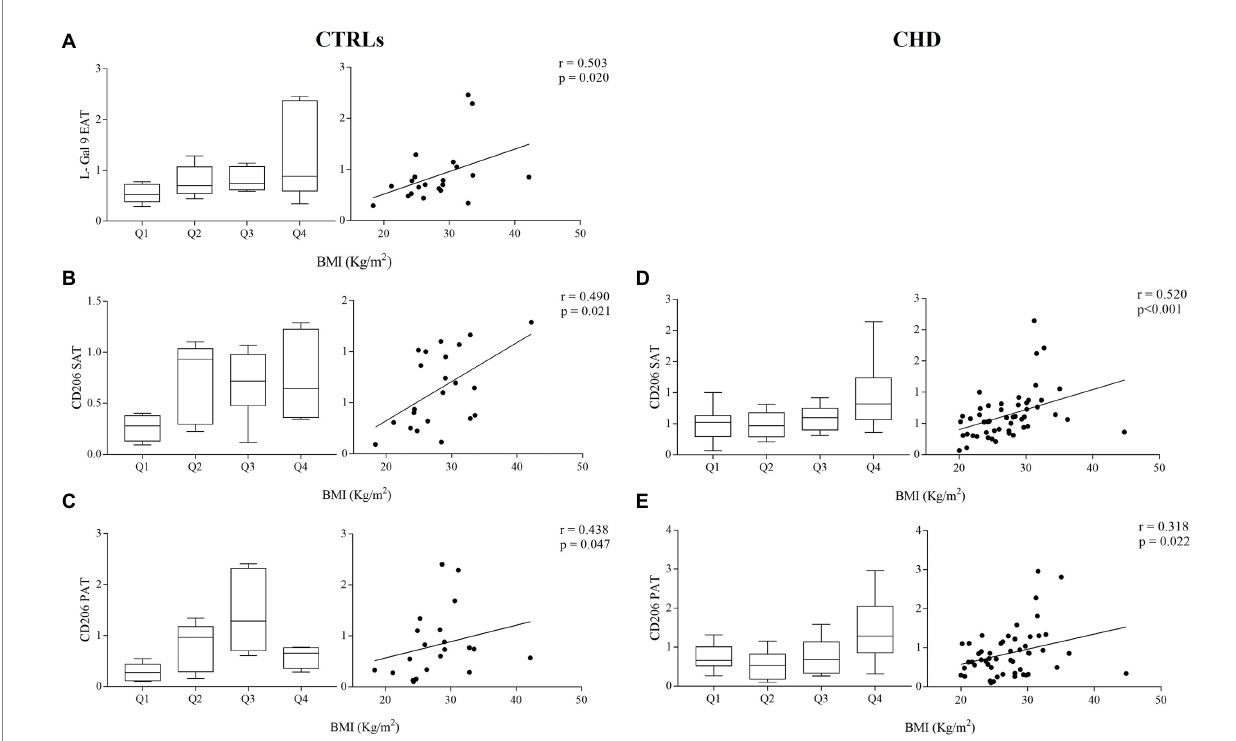
FIGURE 5 Gene expression of L-Gal 9 in CTRLs (A) and CD206 in CTRLs (B,C) and CHD patients (D,E) either stratified based on subject’s BMI quartiles (left graph) or as correlation with continuous BMI values (right graph). Data are reported as RQ values and box plots indicate the median values, 25th and 75th percentiles, while error bars report 10th and 90th percentiles. Spearman ρ analyses were performed and only significant correlations after Bonferroni’s correction (27 comparisons; p < 0.0018) are